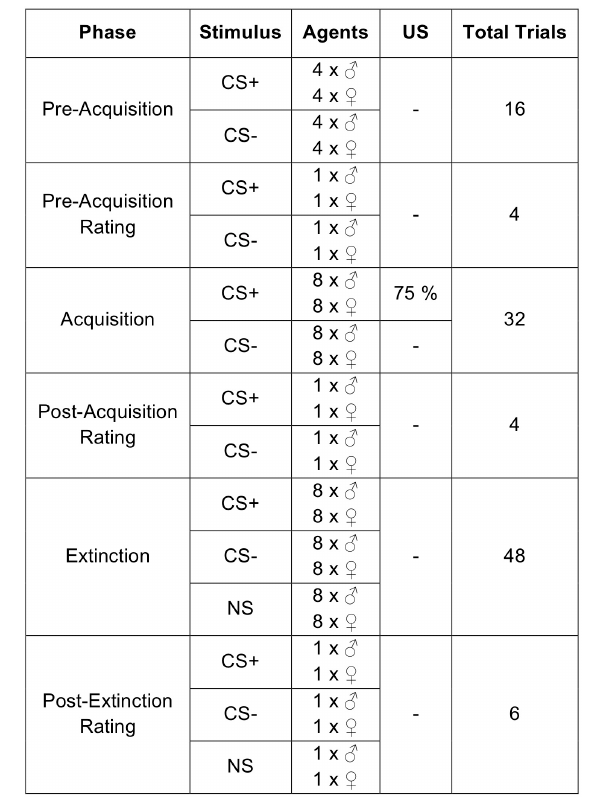
FIGURE 2 | Experimental procedure. As unconditioned stimulus (US) a sound of spitting attended by an air blast followed by the verbal rejection was applied. The order of the agents was pseudorandomized in each phase. CS+ = agent paired with aversive US; CS − = agent without aversive US; NS = agent without aversive US and only appearing during the extinction